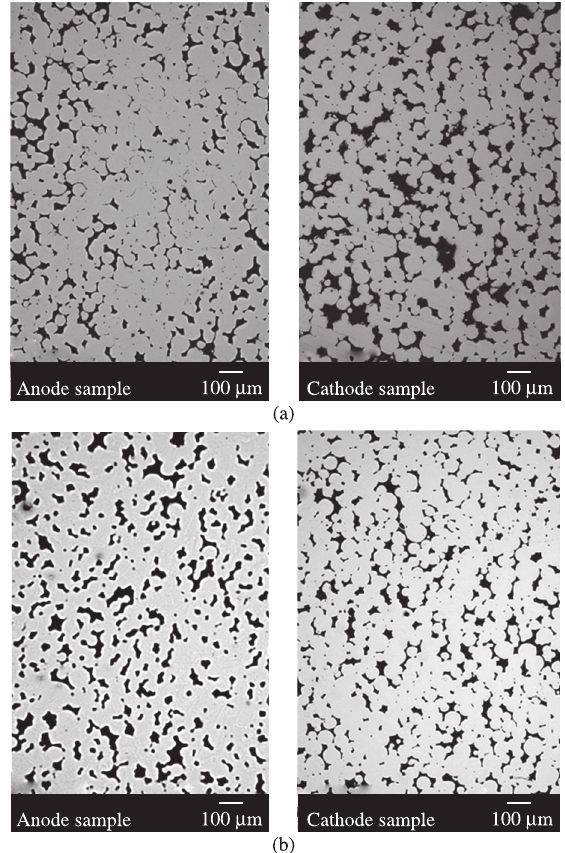
Figure 7. Micrographs of the section of the samples produced without vibra- tion during the powder filling step, sintered at 1423 K for 3600 seconds and compressed at (a) 300 MPa and (b) 600 MPa.